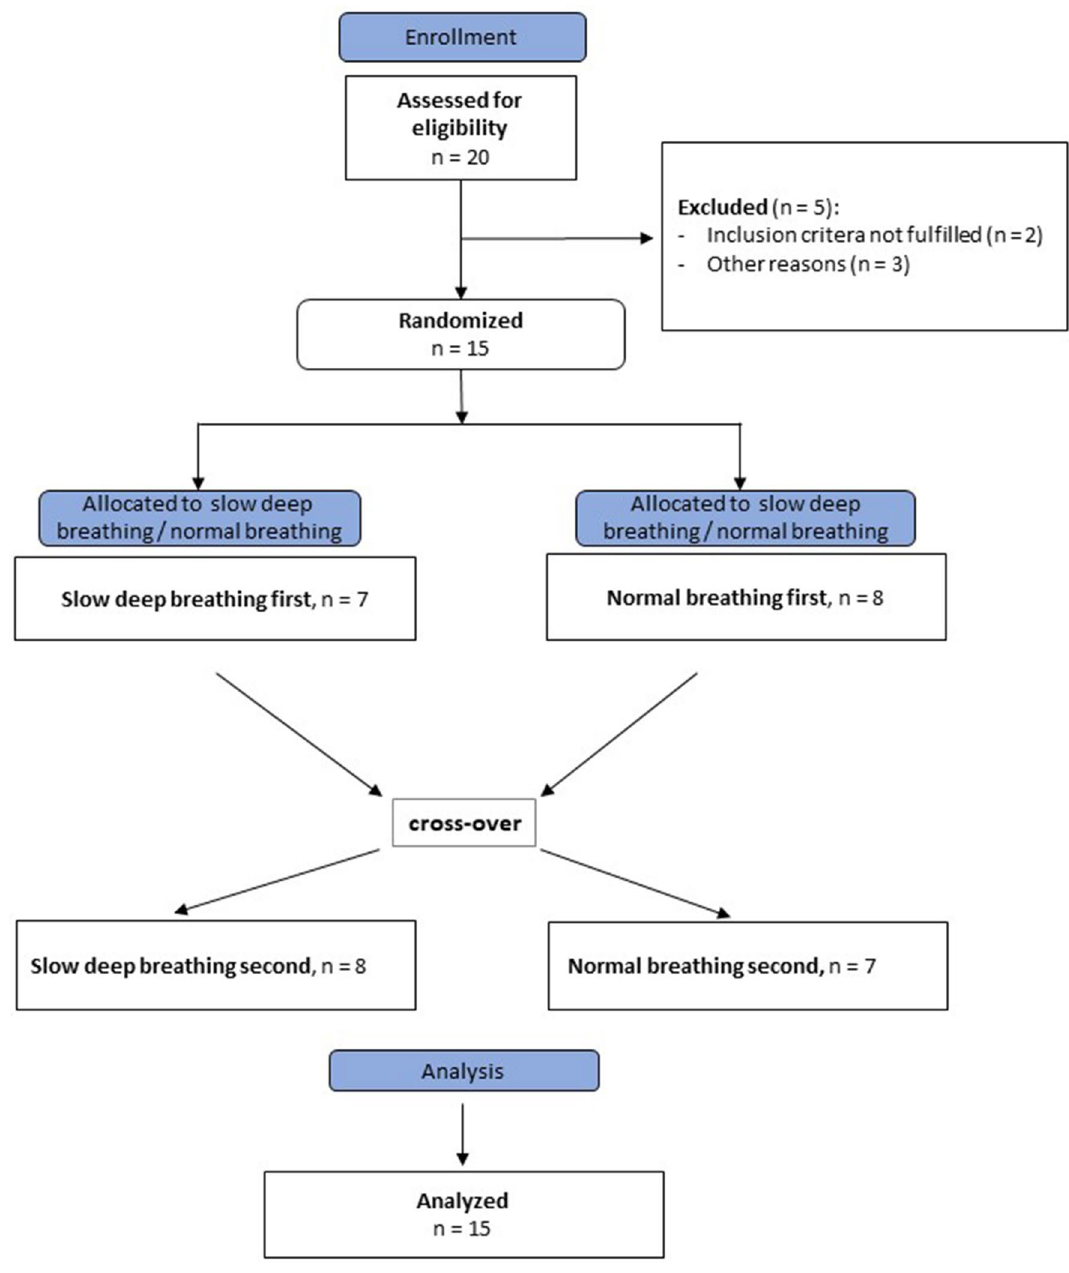
Figure 3. Overview of the course of the